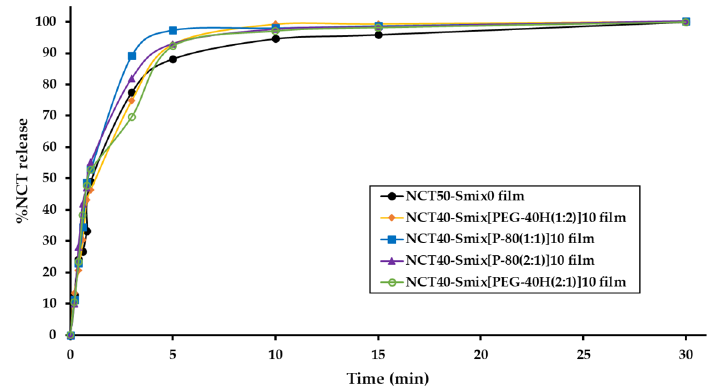
Figure 3. In vitro drug release profile of NCT-ME fast-dissolving films.